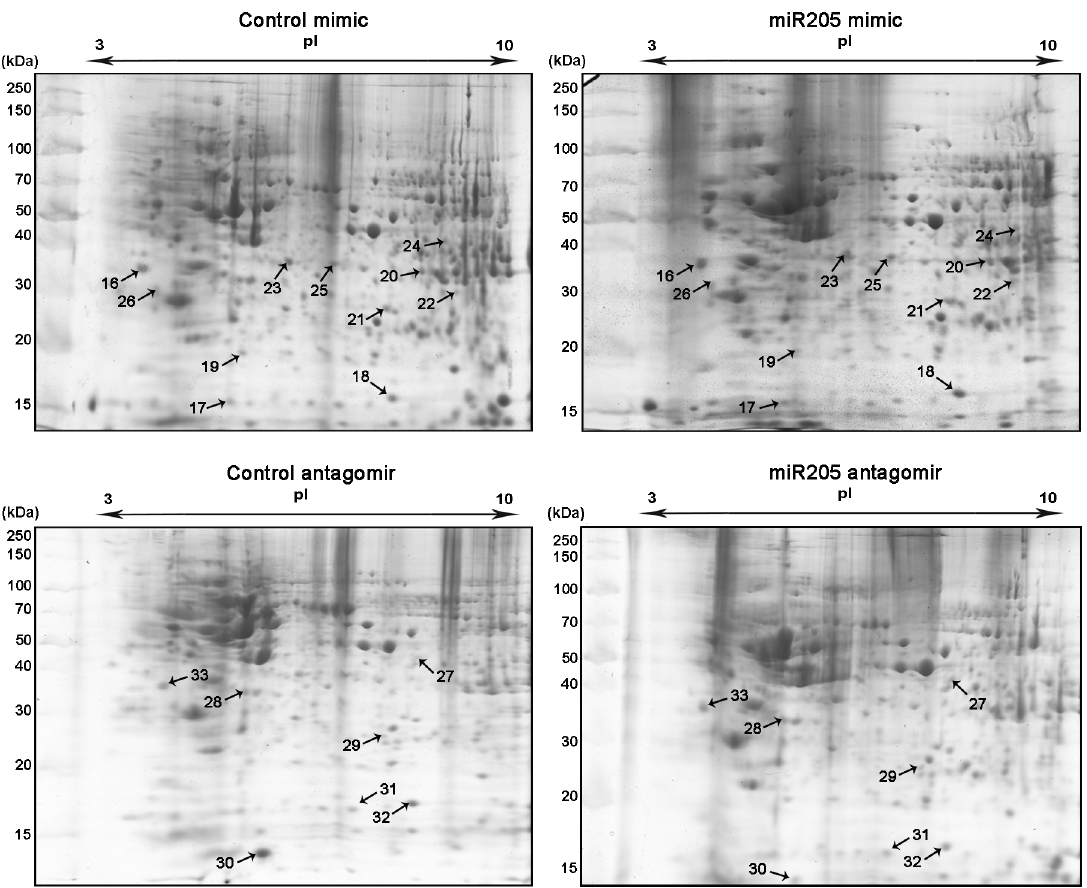
Fig 3. Comparative proteomic profiling in SH-SY5Y. Two-dimensional gels of control mimic, miR-205-5p mimic, control antagomir and miR-205-5p antagomir transfected cells. n = 3 for all experiments. Numbers (16 – 33) represent differentially expressed protein spots identified by MS, reported in Table